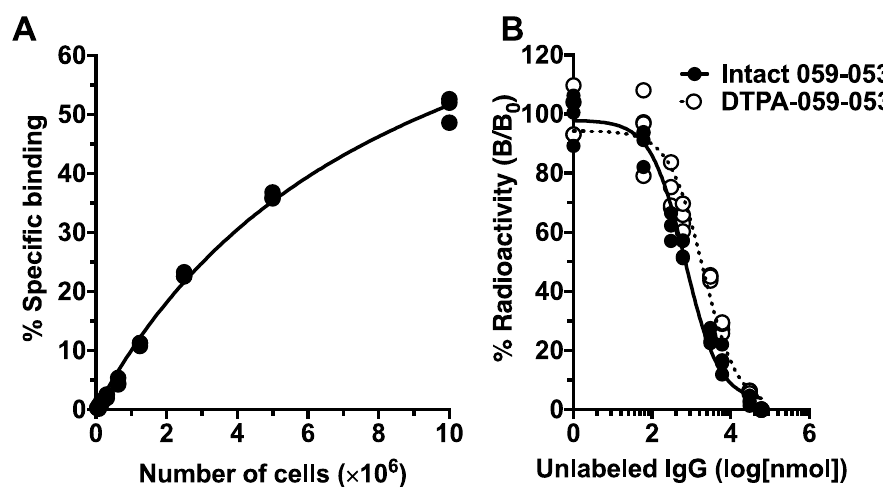
Figure 2. Cell binding and competitive inhibition assays of anti-CD147 antibody 059-053 using BxPC-3 cells. ( A ) Cell binding of 111 In-labeled 059-053 to BxPC-3 cells. The cell suspensions were incubated with 111 In-labeled 059-053 on ice for 60 min, and the radioactivity bound to cells after washing was measured. ( B ) Competitive inhibition assay for intact 059-053 (black circles and solid line) and CHX-A”-DTPA-conjugated 059-053 (white circle and dashed line) using BxPC-3 cells. The 111 In-059-053 was incubated with BxPC-3 cells in the presence of varying concentrations of intact or CHX-A”-DTPA-conjugated 059-053 on ice for 60 min, and the radioactivity bound to the cells was counted after washing.